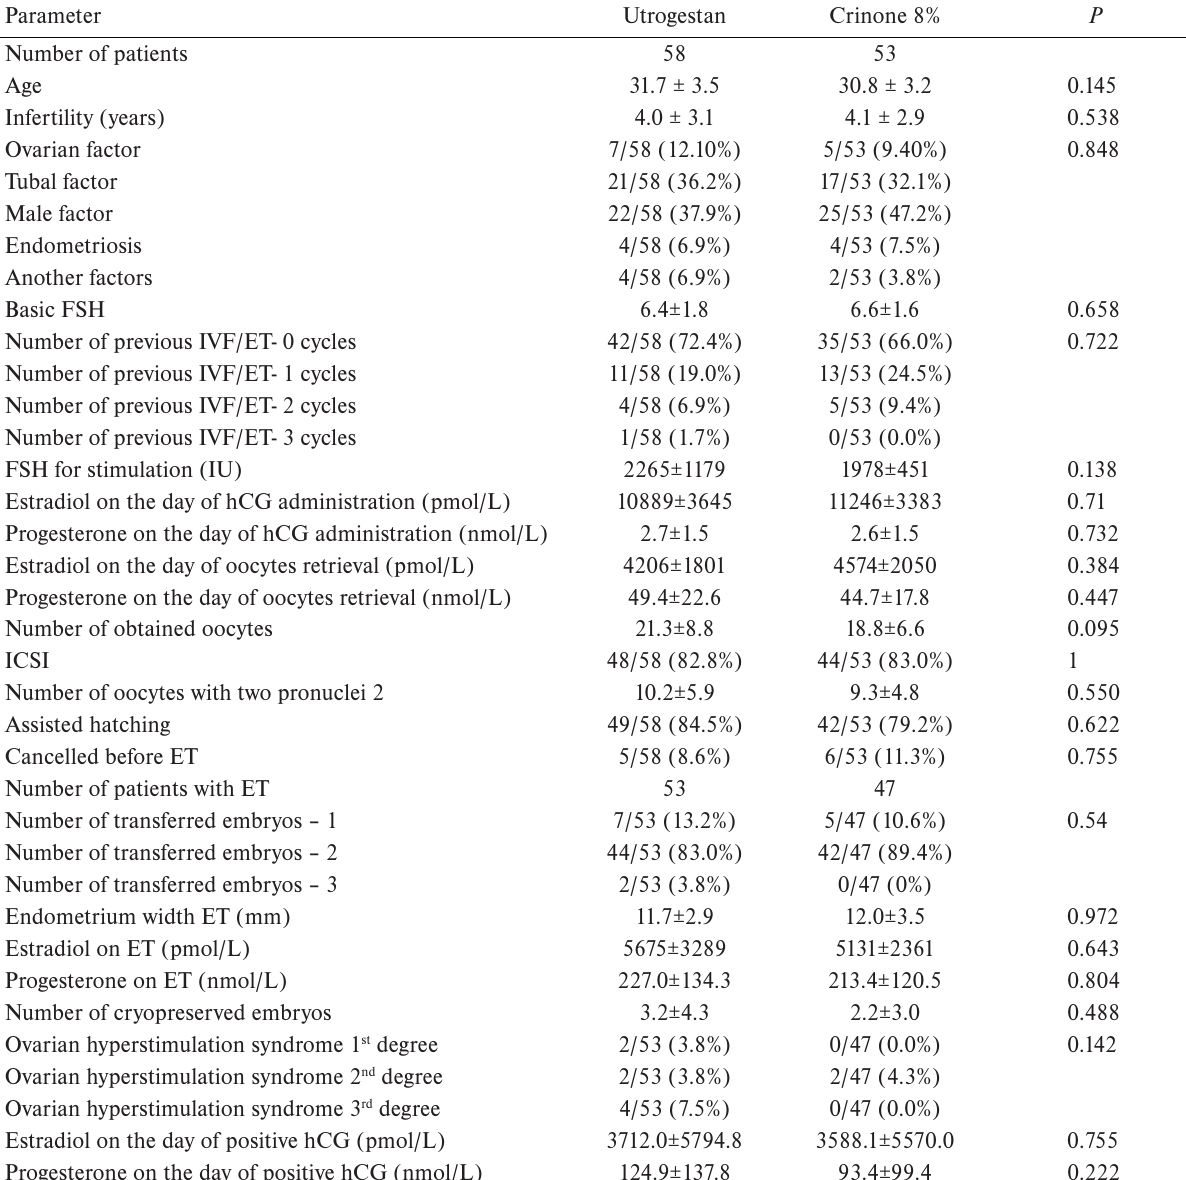
Table 1. Demographic and treatment data for patients using Utrogestan and Crinone